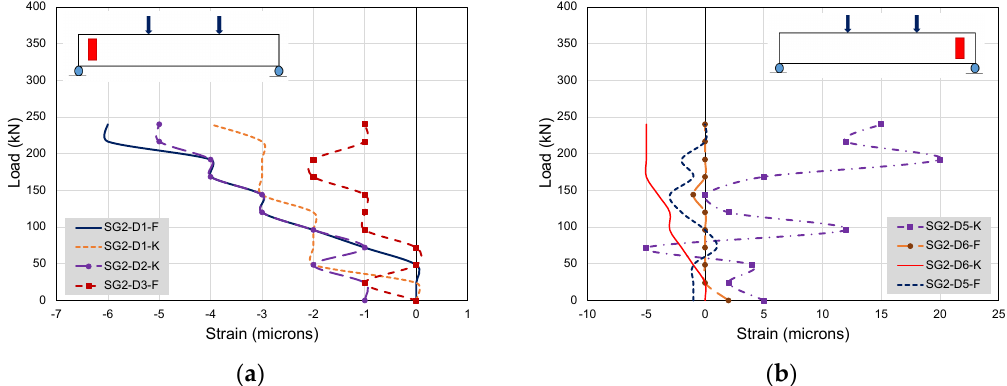
Figure 28. Load versus strain responses in load setup SP-2-L01 ( a ) D1–D3, and ( b ) D5–D6.